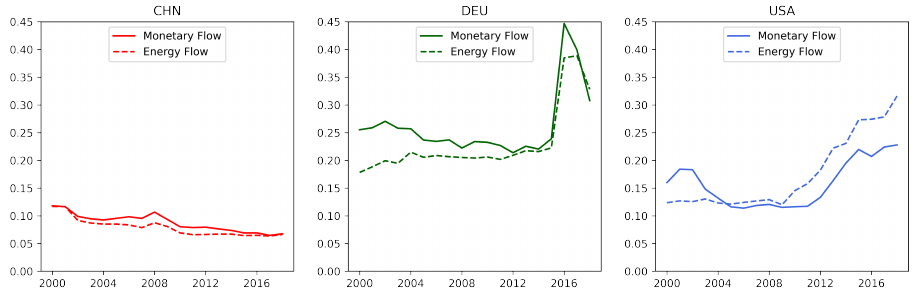
Figure 13. The evolution of individual country HHI for the fossil energy import.